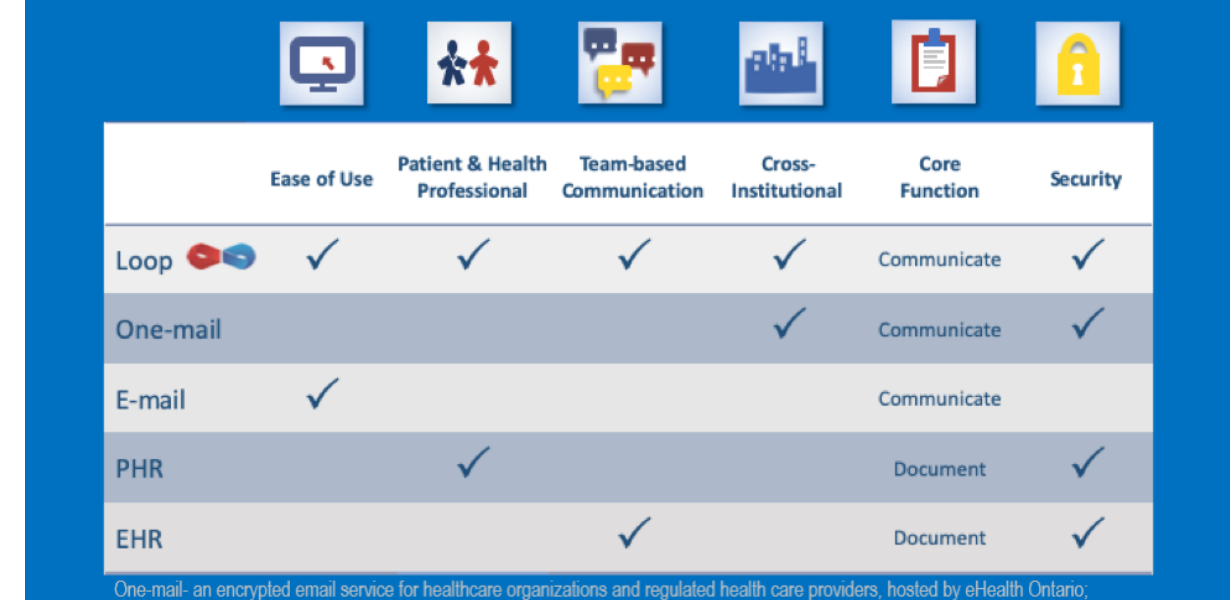
Figure 3. Comparison of Loop with other categories of eHealth